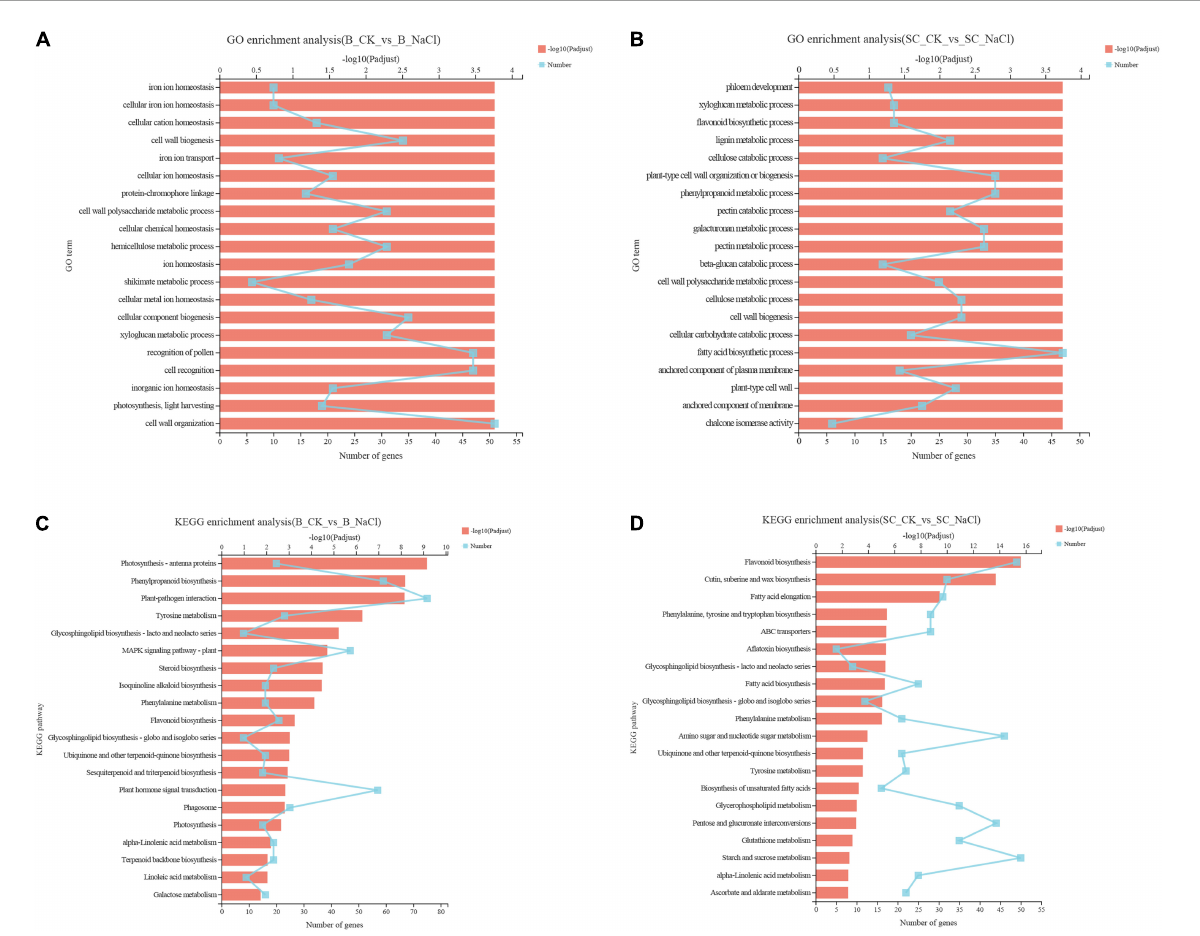
FIGURE4 Gene Ontology enrichment analysis and KEGG pathway analysis of differentially expressed genes in strawberry leaves under salt stress. ‘Sweet Charlie’ and ‘Benihoppe’ plants with 6–7 leaves were treated with 0 mM (control) or 100 mM NaCl solution, respectively. After 12 h of treatment, the young leaves were collected for RNA-seq analysis. GO enrichment analysis and KEGG pathway analysis were performed to explore the functional significance of DEGs. Top 20 GO enrichment terms of differentially expressed genes in ‘Benihoppe’ (A) and ‘Sweet Charlie’ (B) under salt stress. Top 20 KEGG pathways of differentially expressed genes in ‘Benihoppe’ (C) and ‘Sweet Charlie’ (D) under salt